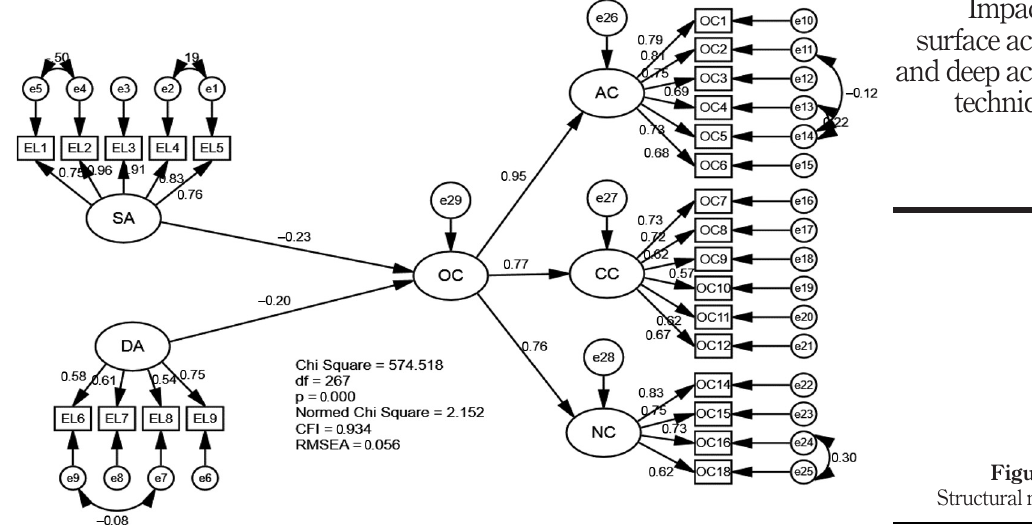
Figure 1. Structural